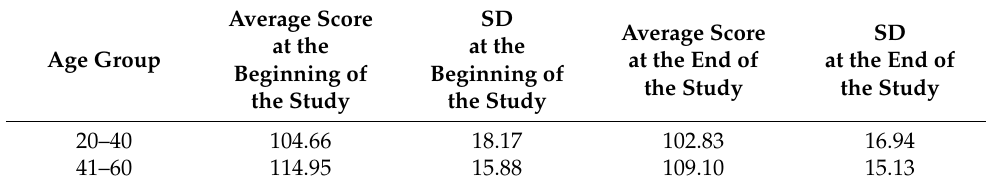
Table 3. The results of the stress questionnaire by age